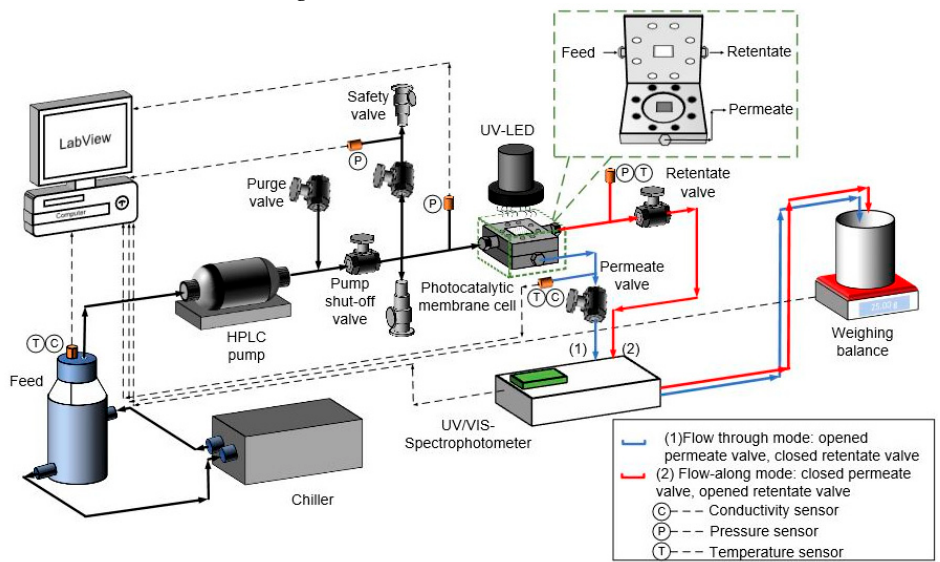
Figure 8. Schematic of the continuous flow process showing pump, valves, sensors (temperature, pressure and conductivity), photocatalytic cell and spectrophotometer arrangement during the different modes of the photocatalytic experiments. Schematic for batch reactor refers to Figure 1A.